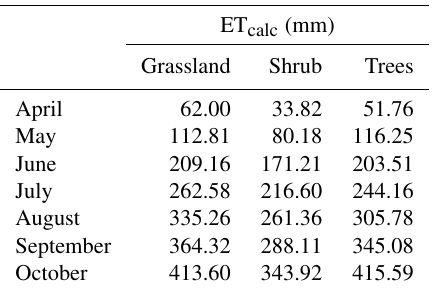
Table 4. Accumulated ET calc over the growing period of